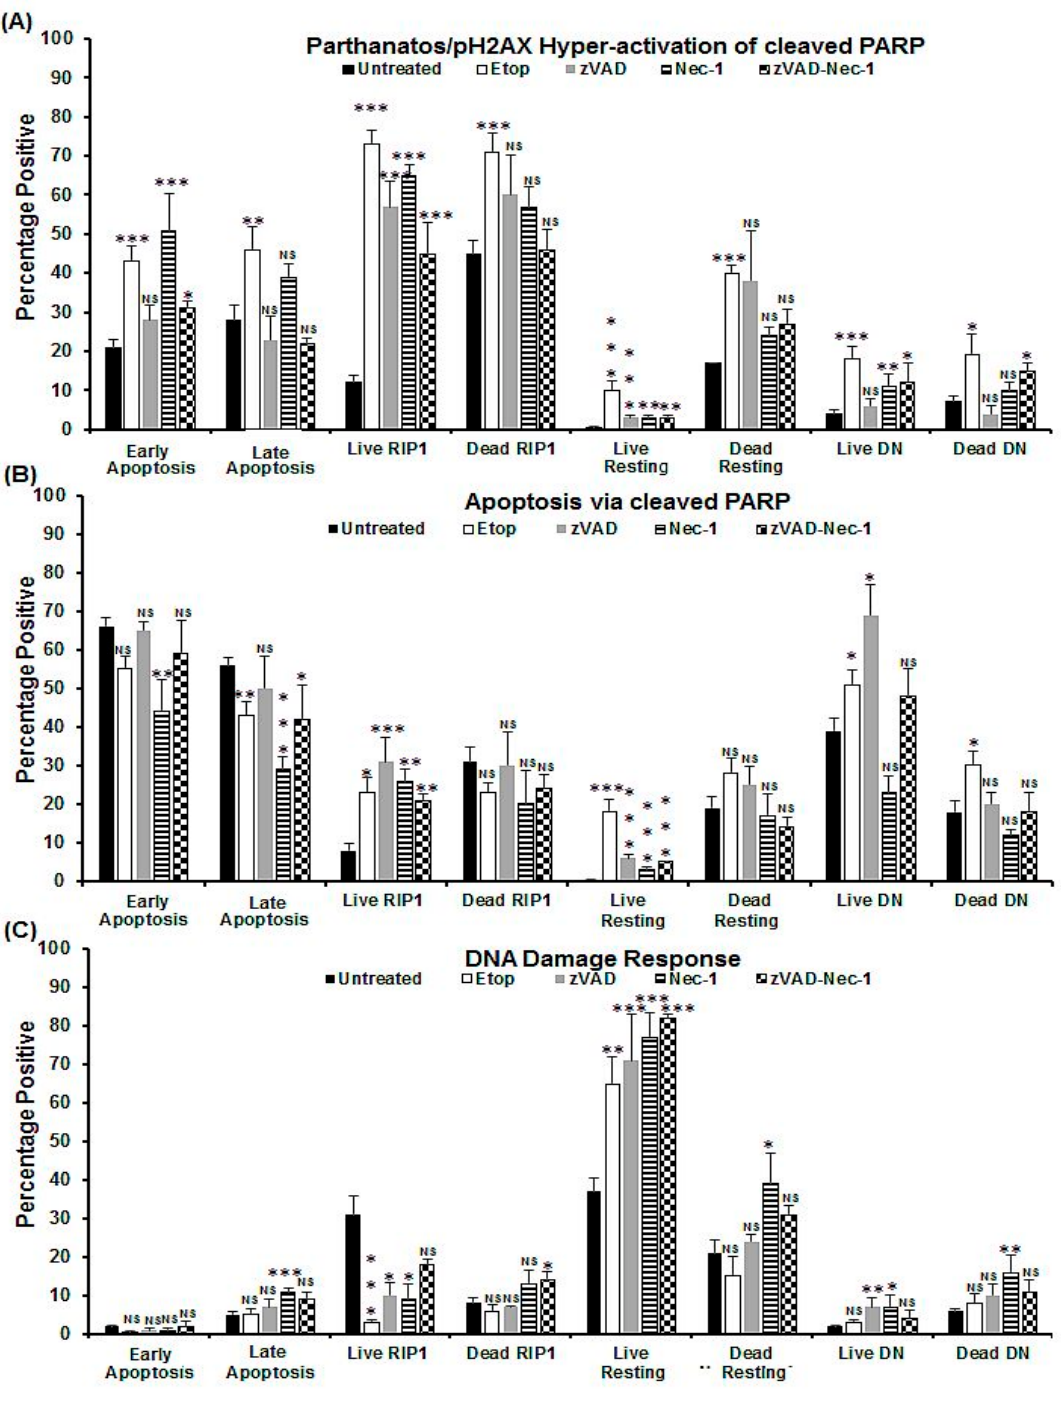
Figure 5. Parthanatos / hyper-activation of cleaved PARP, apoptosis via cleaved PARP, and DDR analysis of apoptosis. Untreated Jurkat, treated with 1 µ M Etop or pre-treated with zVAD (20 µ M) and / or Nec-1 (60 µ M) for 2 h, then incubated with 1 µ M Etop for 24 h. Gating on live and dead cells from a Zombie NIR vs. caspase-3-BV650 plot then both were analysed on a RIP3-PE vs. caspase-3-BV650 plot. Early and late apoptotic, necroptotic / resting, RIP1-dependent apoptotic, and double negative (DN) populations were analysed for pH2AX and cleaved PARP (Figures S2,S4 for detailed information). The incidence of ( A ) parthanatos / hyper-activation of cleaved PARP, ( B ) apoptosis via cleaved PARP, and ( C ) DDR were determined for all populations listed above. Mean, error bars % SEM, Student’s t -test: NS (not significant), * p < 0.05, ** p < 0.01**, *** p < 0.001 compared with untreated cells.